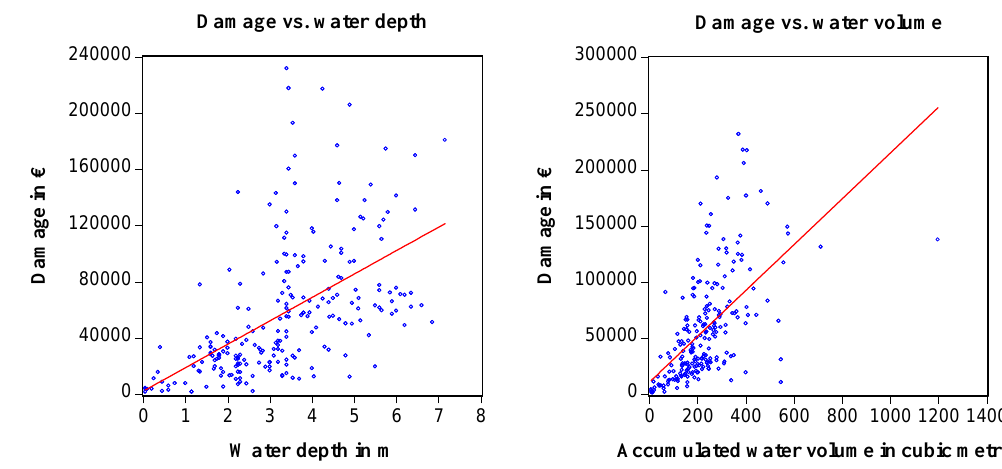
with bandwidth h) for regular damage. Data source: Amt der NÖ Landesregierung, Abteilung